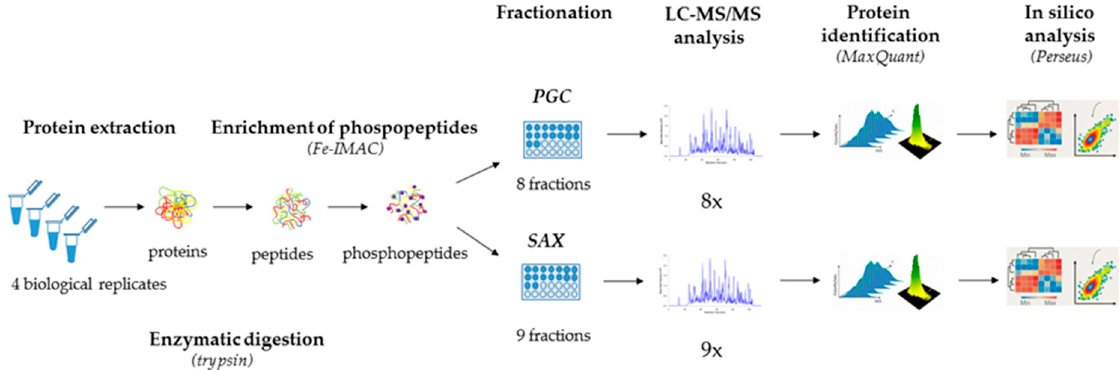
Figure 1. Workflow of label-free quantitative (LFQ) phosphoproteomics of the fission yeast Schizosaccharomyces pombe . The protocol involves the following steps: protein extraction, phosphopeptide enrichment (Fe-IMAC), PGC and SAX fractionations, LC-MS/MS analysis, protein identification, and in silico analysis.